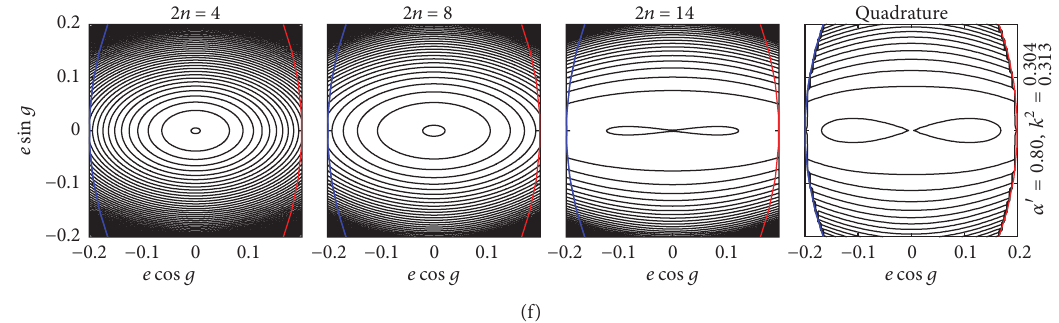
Figure 2: Equipotential curves computed through the doubly averaged disturbing function and plotted on the plane (𝑥,𝑦) = (𝑒 cos 𝑔, 𝑒 sin 𝑔) . Columns are, from the left, 2𝑛 = 2 (for (a), (b)) or 2𝑛 = 4 (for (c), (d), (e), and (f)), 2𝑛 = 8 , 2𝑛 = 14 , and the numerical quadrature defined by (52). Rows are, from the top, (a) (𝛼,𝑘 2 ) = (0.90, 0.900) , (b) (𝛼,𝑘 2 ) = (0.90, 0.400) , (c) (𝛼 󸀠 ,𝑘 2 ) = (0.70, 0.600) , (d) (𝛼 󸀠 , 𝑘 2 ) = (0.60, 0.265) , (e) (𝛼 󸀠 ,𝑘 2 ) = (0.60, 0.260) , and (f) (𝛼 󸀠 , 𝑘 2 ) = (0.80, 0.304) for the analytic expansion and (𝛼 󸀠 ,𝑘 2 ) = (0.80, 0.313) for the numerical quadrature. The black dashed circles represent the theoretical maximum eccentricity (𝑒 max ) of each of the systems. The red and the blue partial circles represent the conditions where the orbits of perturbed and perturbing bodies cross at the ascending node (red) and at the descending node (blue) of the perturbed